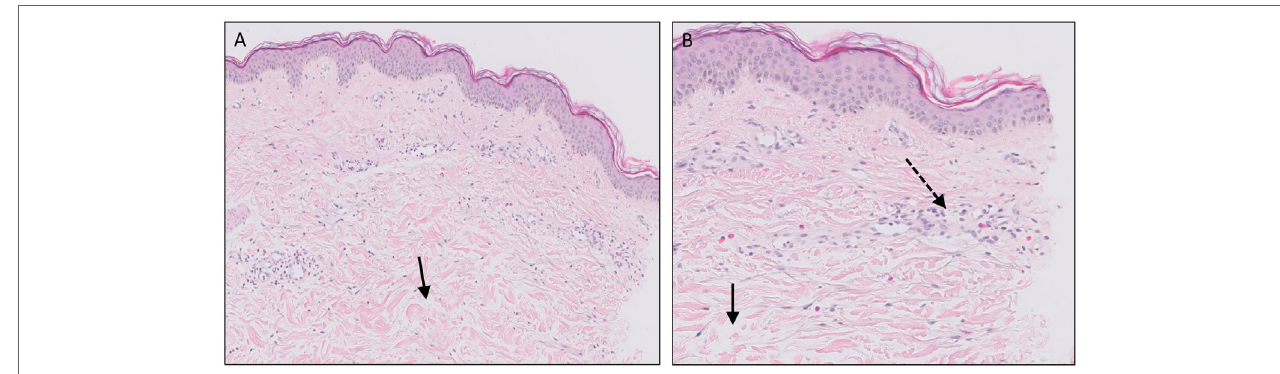
FigURe 5 | Urticaria. Dermal edema [solid arrows in (A,B) ] and a sparse superficial predominantly perivascular and interstitial infiltrate of lymphocytes and eosinophils without signs of vasculitis (dashed